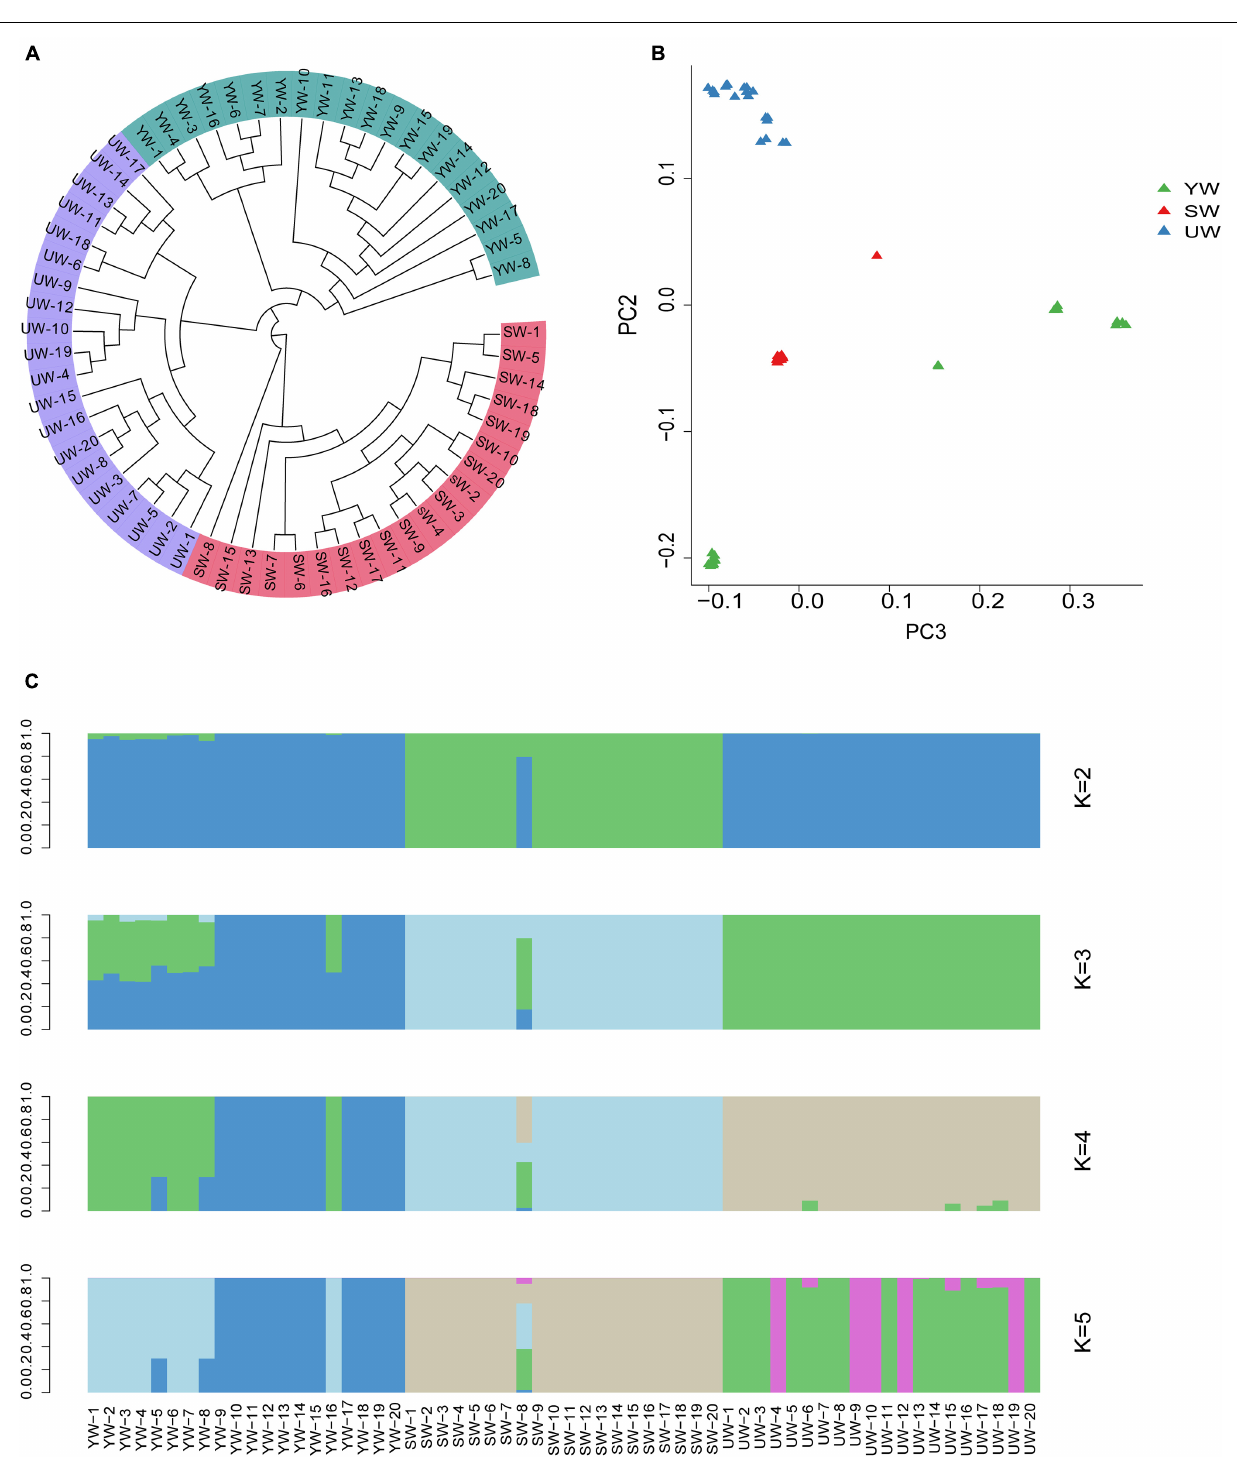
Frontiers in Plant Science |